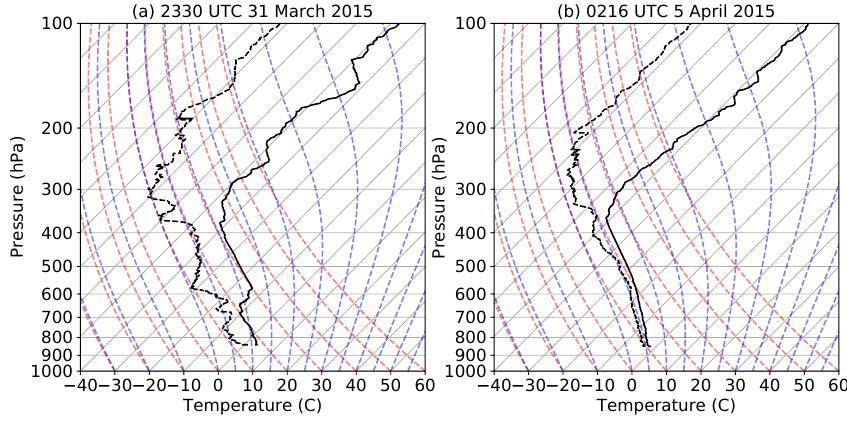
Figure 4. The soundings launched at (a) 23:30UTC 31 March 2015 (westerly flow event) and (b) 02:16UTC 5 April 2015 (easterly flow